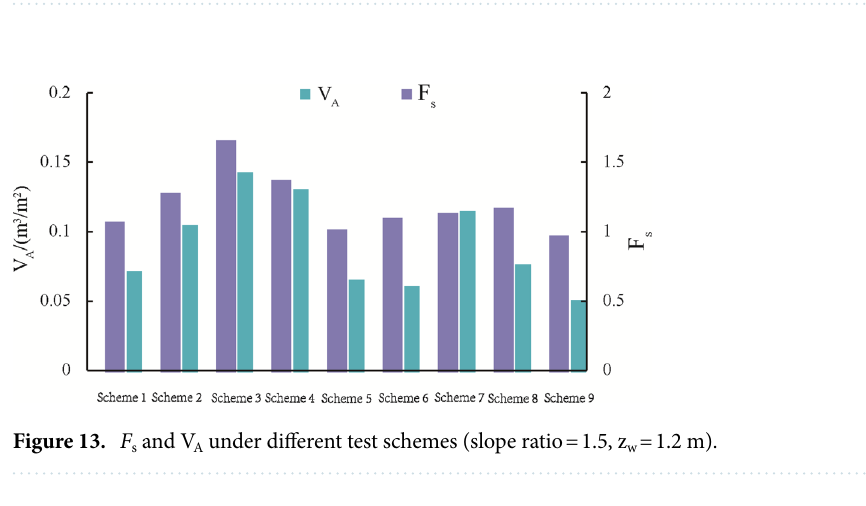
Table 5. Primary and secondary relations of geometric parameters.